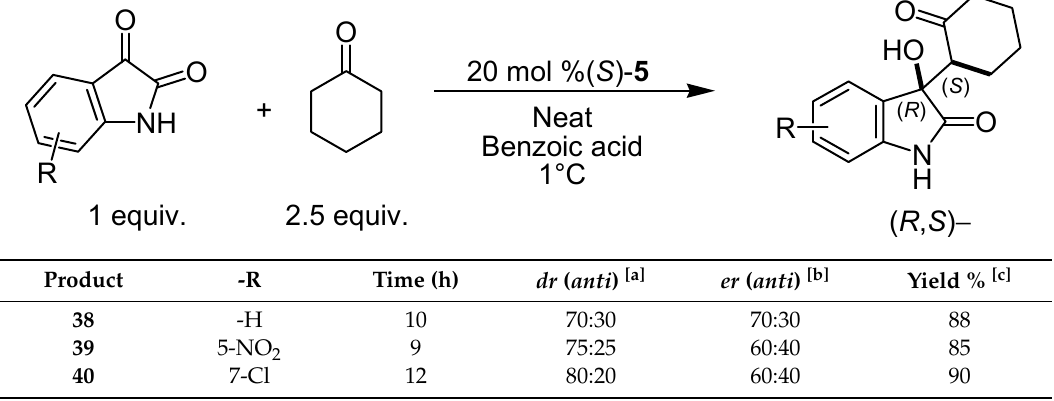
Table 5. Asymmetric aldol reaction between acetone and aromatic aldehydes employing silica- supported ( S ) -5 as